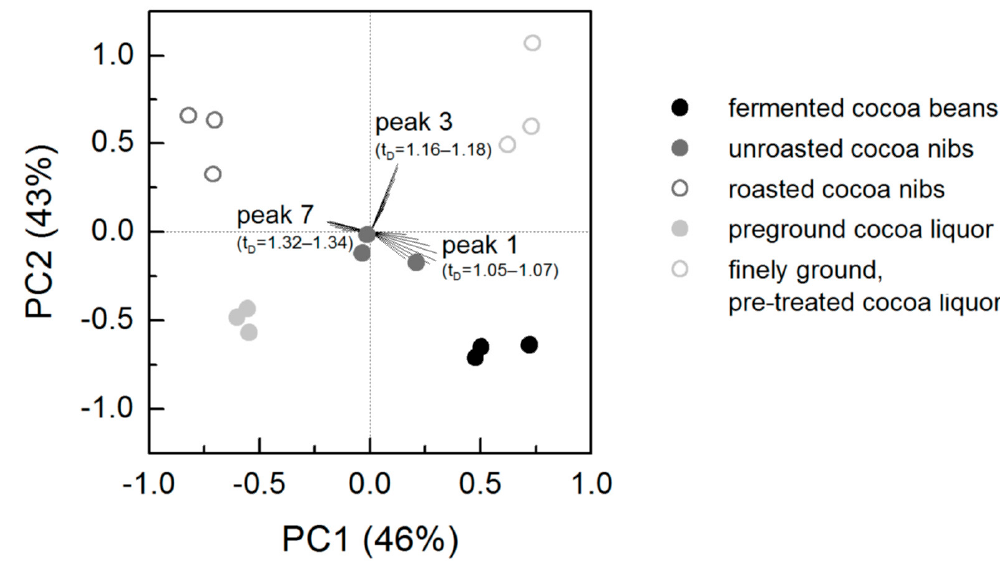
Figure 4. Principal component analysis of IM spectra of bulk cocoa ( n = 3).